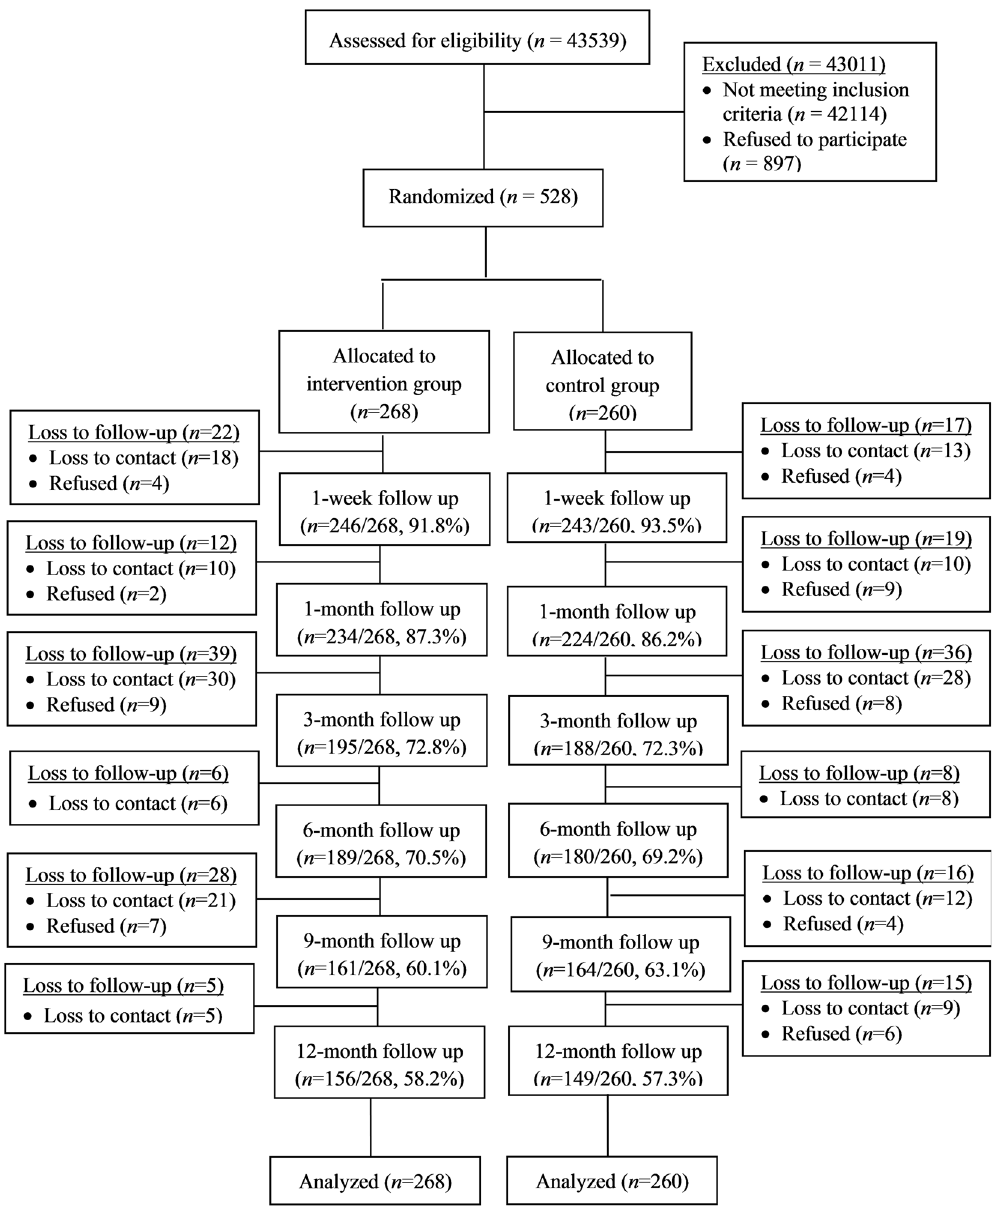
Figure 1. The Consolidation of Standards for Reporting Trials (CONSORT)